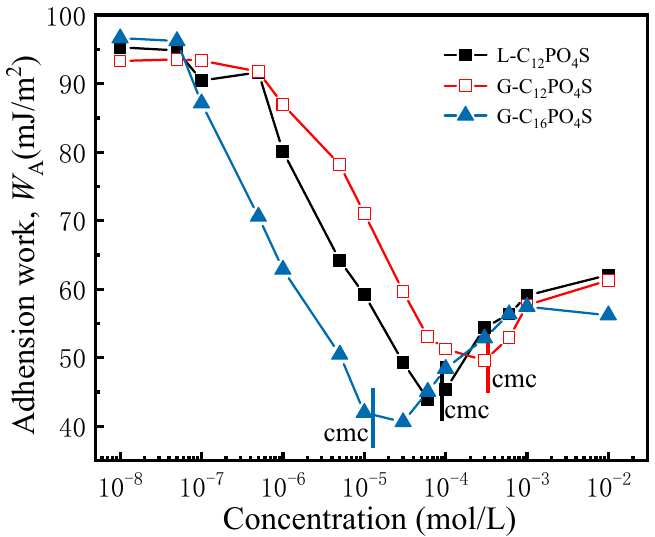
Figure 5. Effect of concentration on the adhesion work of the extended surfactants at the PMMA surface.